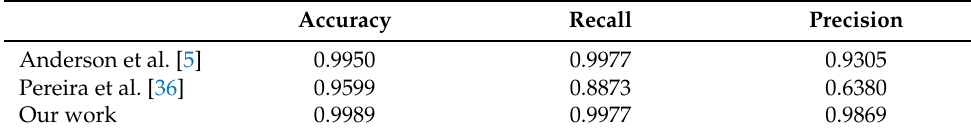
Table 5. Experimental